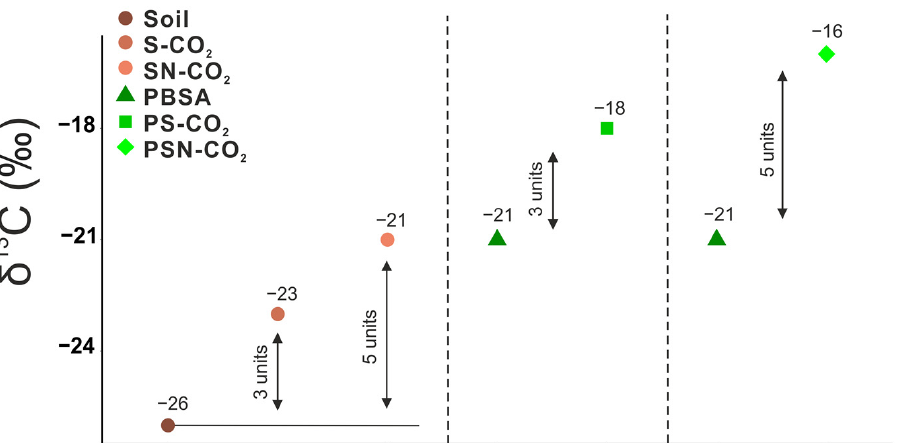
Figure 1. Isotope signature of 13 C sources: Soil— δ 13 C in soil, S-CO 2 — δ 13 C in CO 2 respired from soil without N addition, SN-CO 2 — δ 13 C in CO 2 respired from soil with N addition, PBSA— δ 13 C of PBSA, PS-CO 2 —an estimated shift in δ 13 C of PBSA in CO 2 respired from soil in the PS treatment; PSN-CO 2 —an estimated shift in δ 13 C of PBSA in CO 2 respired from soil in PSN